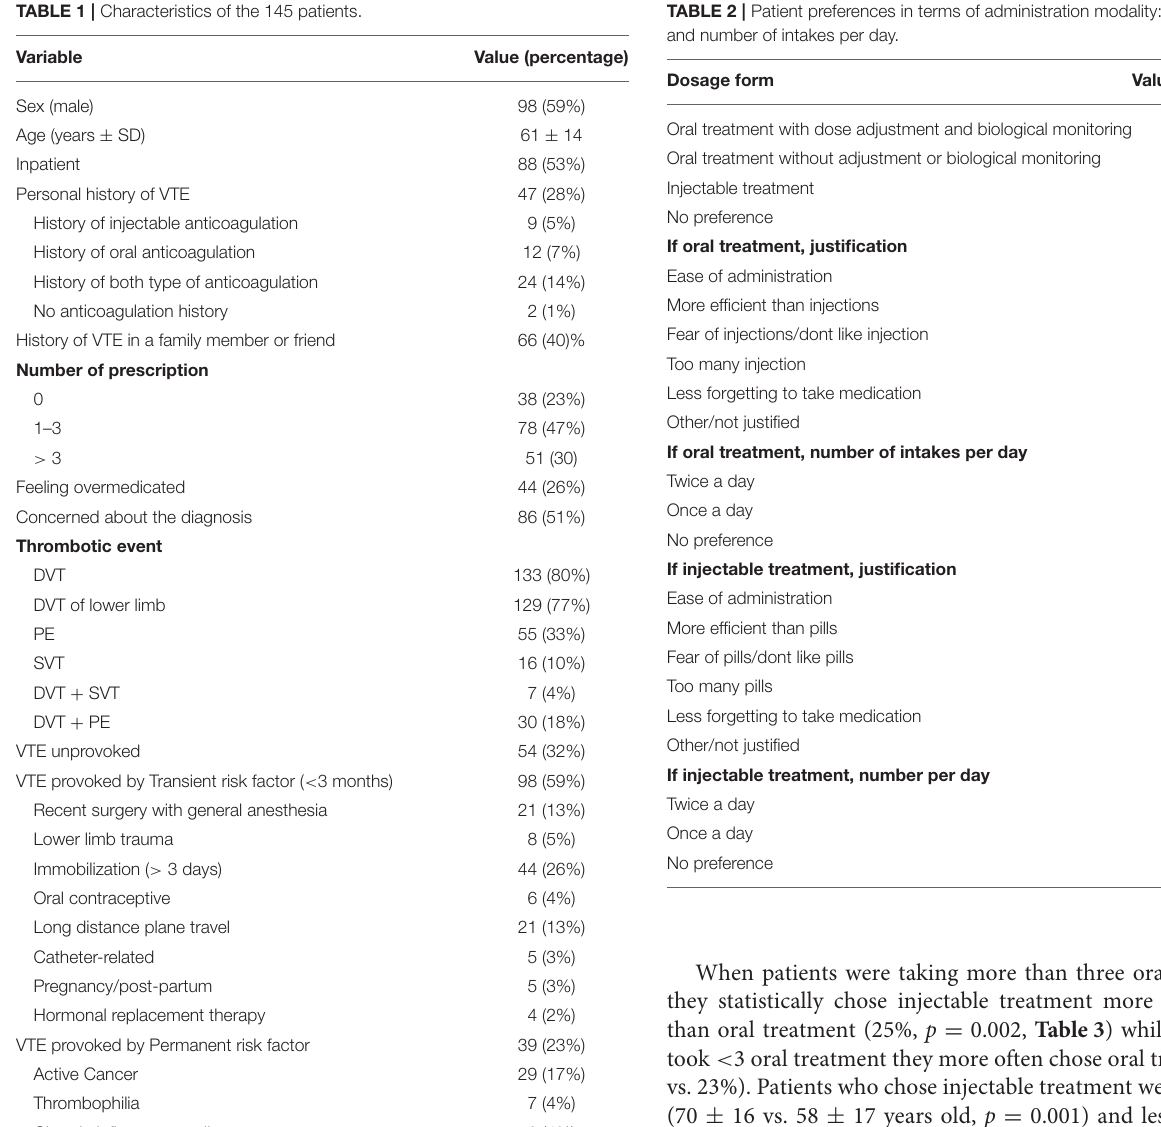
TABLE 1 | Characteristics of the 145 patients. TABLE 2 | Patient preferences in terms of administration modality: dosage form